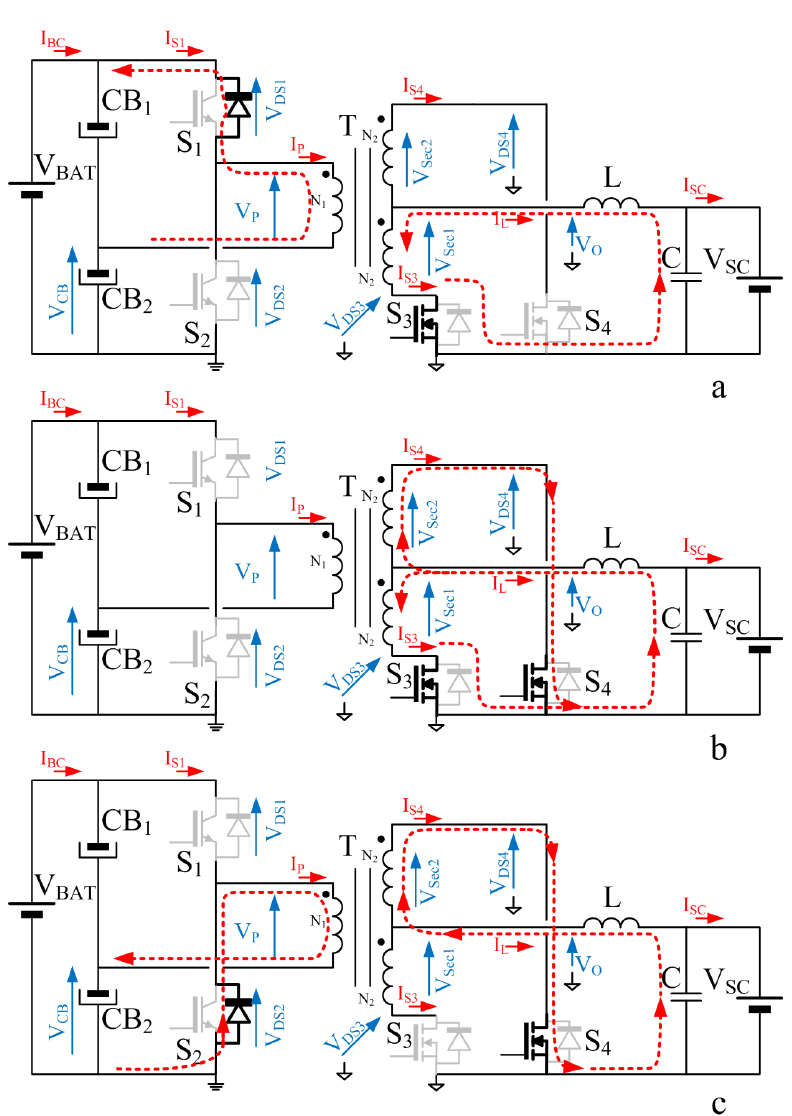
Figure 5. Switching modes of the half-bridge current-source (HBCS) converter operating during supercapacitor (SC) discharging operation mode. ( a ) Switch S 3 on and switch S 4 off. ( b ) Both switches S 3 and S 4 turned on. ( c ) Switch S 3 off and switch S 4